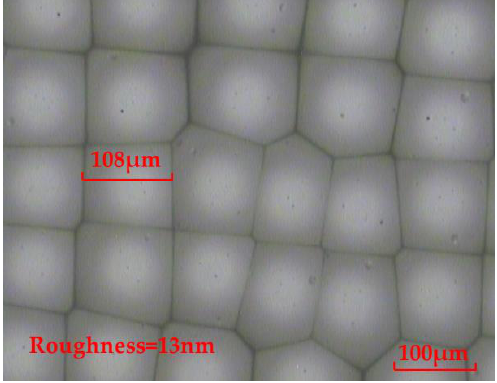
Figure 4. The rMLA fabricated by the HNO 3 chemical etching solution.